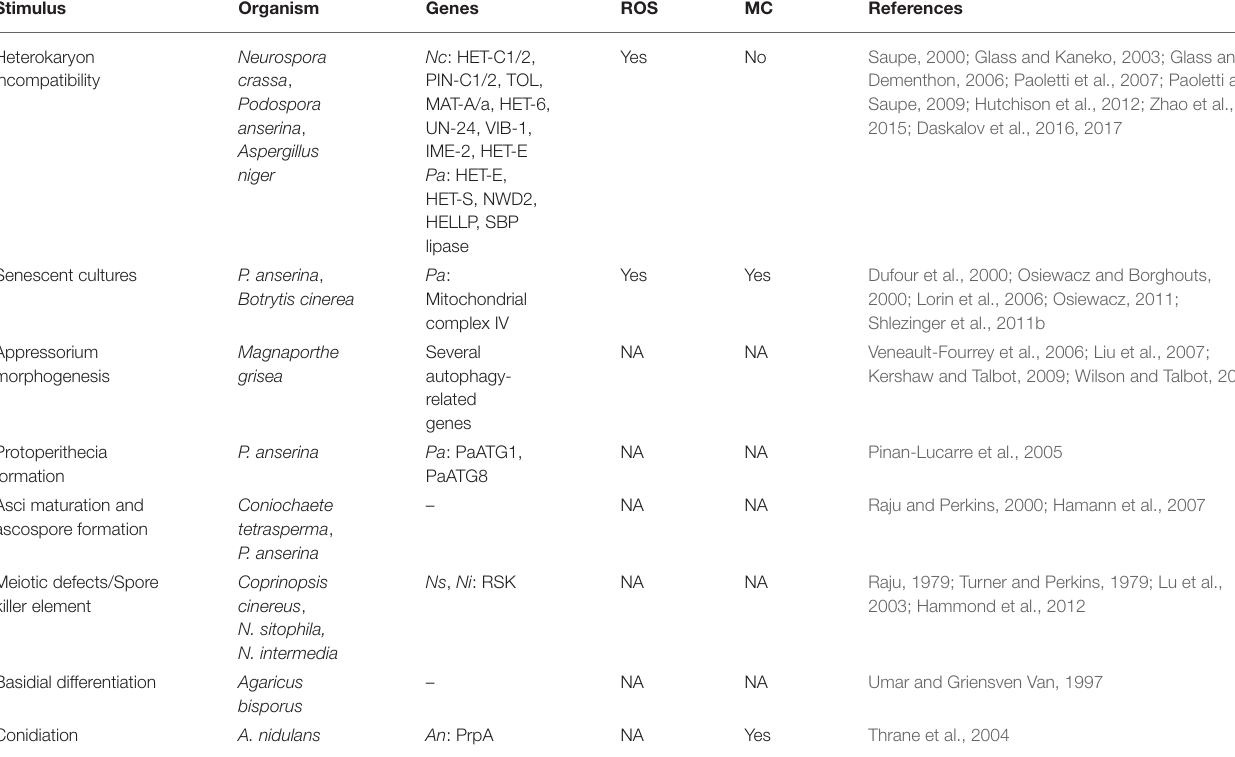
TABLE 1 | PCD in filamentous fungi during differentiation or developmental